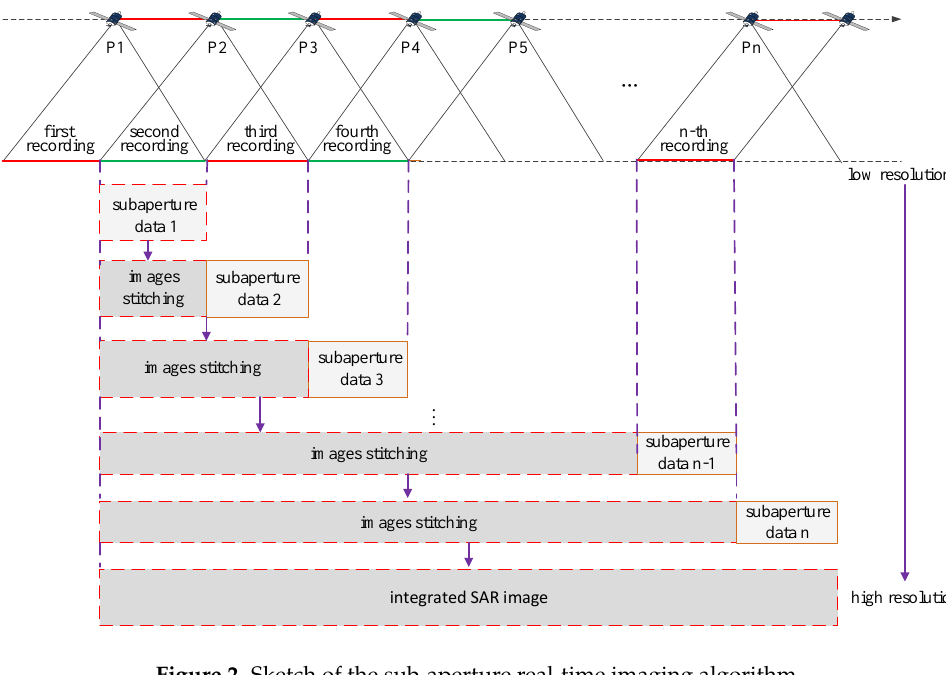
Figure 2. Sketch of the sub-aperture real-time imaging algorithm.